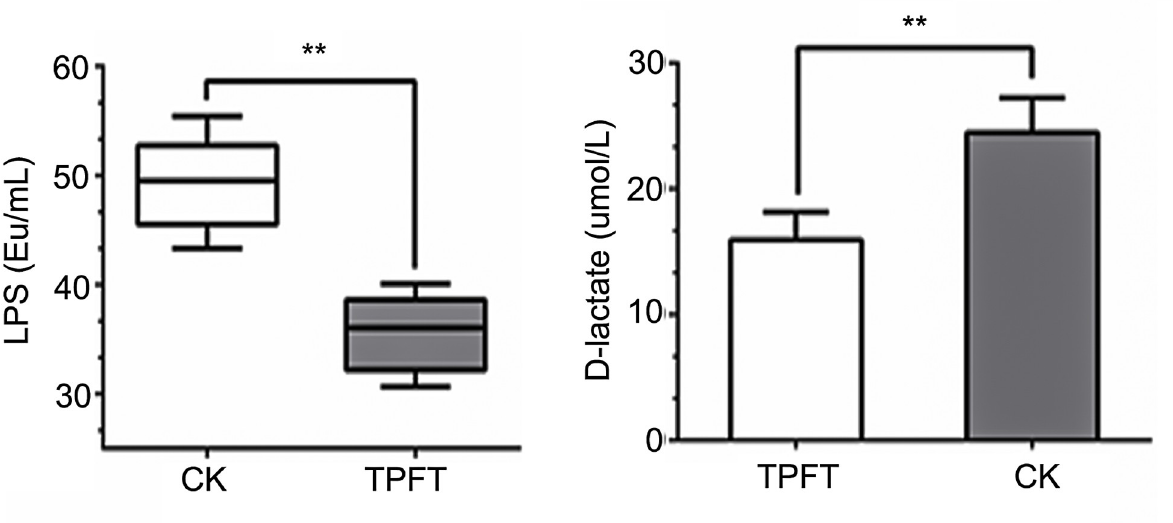
Fig 5. The effect of exclusive enteral nutrition (EEN)-n-3 polyunsaturated fatty acids (3PUFAs) on intestinal barrier functions 8 weeks after treatment based on lipopolysaccharides and D-lactic acid levels. �� , P < 0.01. 3PUFAs-8 week: The experimental group treated with 3PUFAs for 8